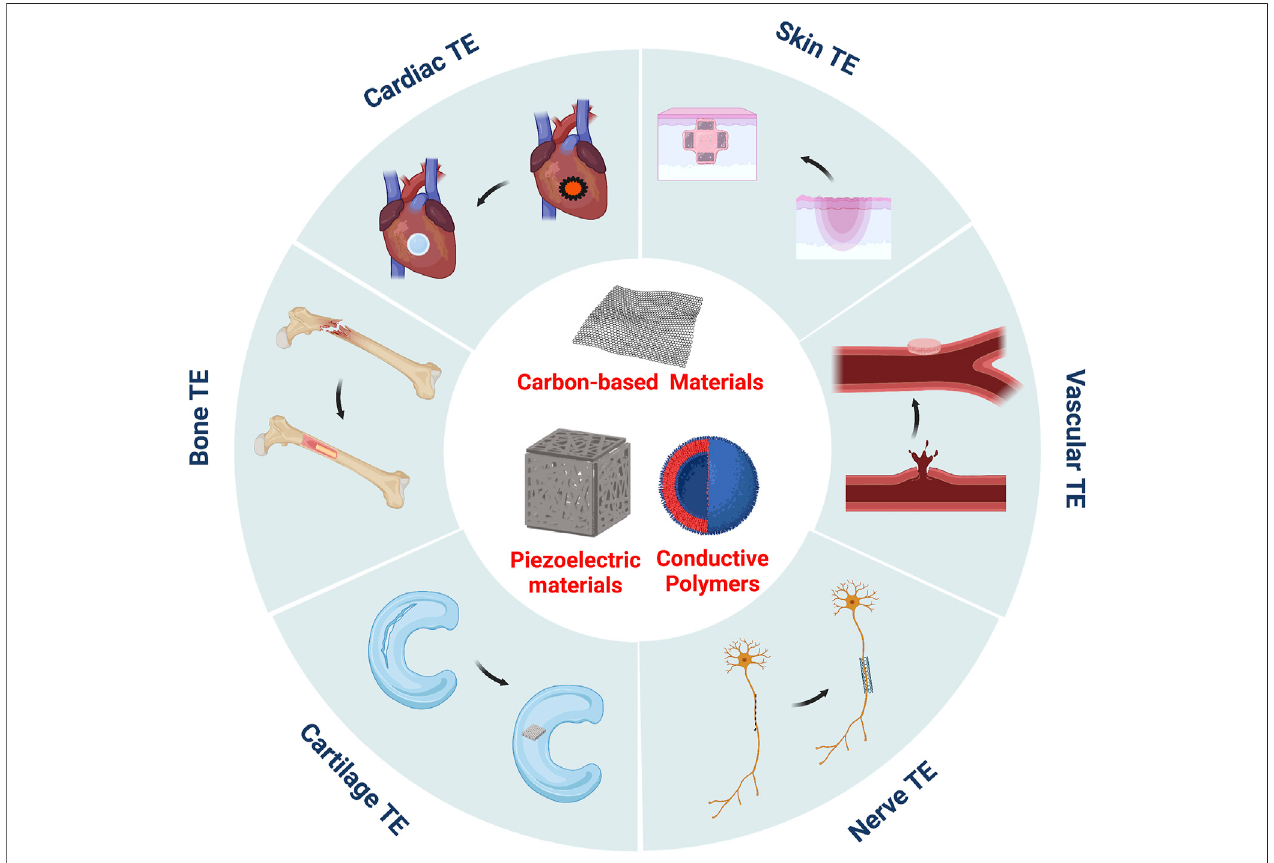
FIGURE 1 | Electroactive biomaterials have been widely used in the TE of skin, bone, cartilage, nerve tissue, cardiac or blood vessels.